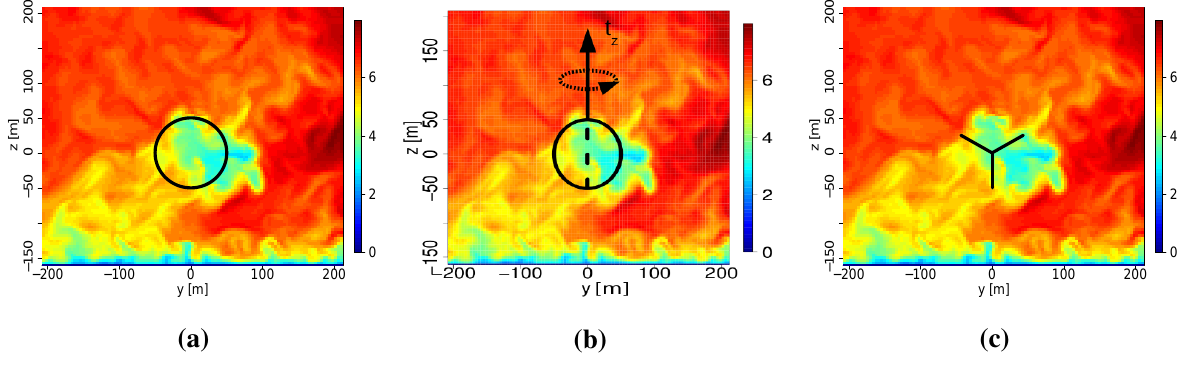
Figure 6. Illustrations corresponding to the different measures: ( a ) Measures u eff, P and τ are obtained through averaging over a disk in the wake flow; ( b ) τ t on a disk in the flow. The dashed line represents the rotational axis; ( c ) The measure T z results from averaging over three rotor blades in the flow. The blades rotate at 10 rpm.